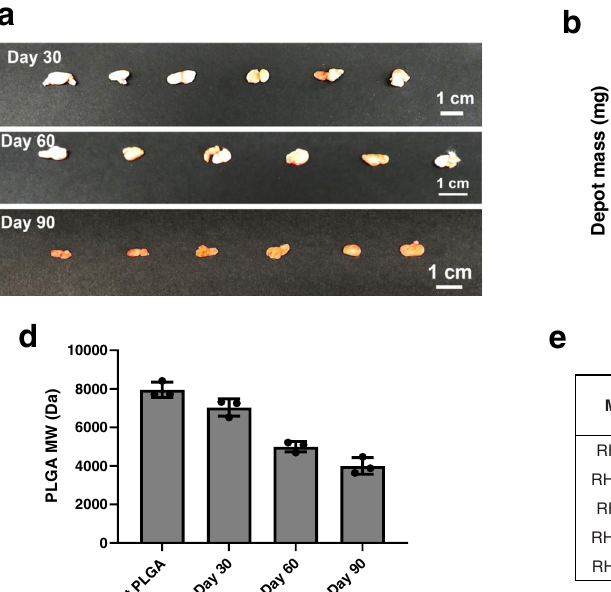
c Quanti fi cationofresidualCABinISFIs30-,60-,and90-dayspost-injectioninmice (average ± standard deviation of n =3 samples) comparedto initial dose (25mg in 50 µ Linjection). d DecreaseinPLGAmolecularweightinCABISFIs30-,60-,and90- days post-injection in mice (average ± standard deviation of n =3 samples) com- paredtoneatPLGA(10kDa). e Residualdrugquanti fi cationofimplants(injectedin the left and right upper back location) retrieved from three rhesus macaques 84- and 98-days post-injection. Source data are provided as a Source Data fi